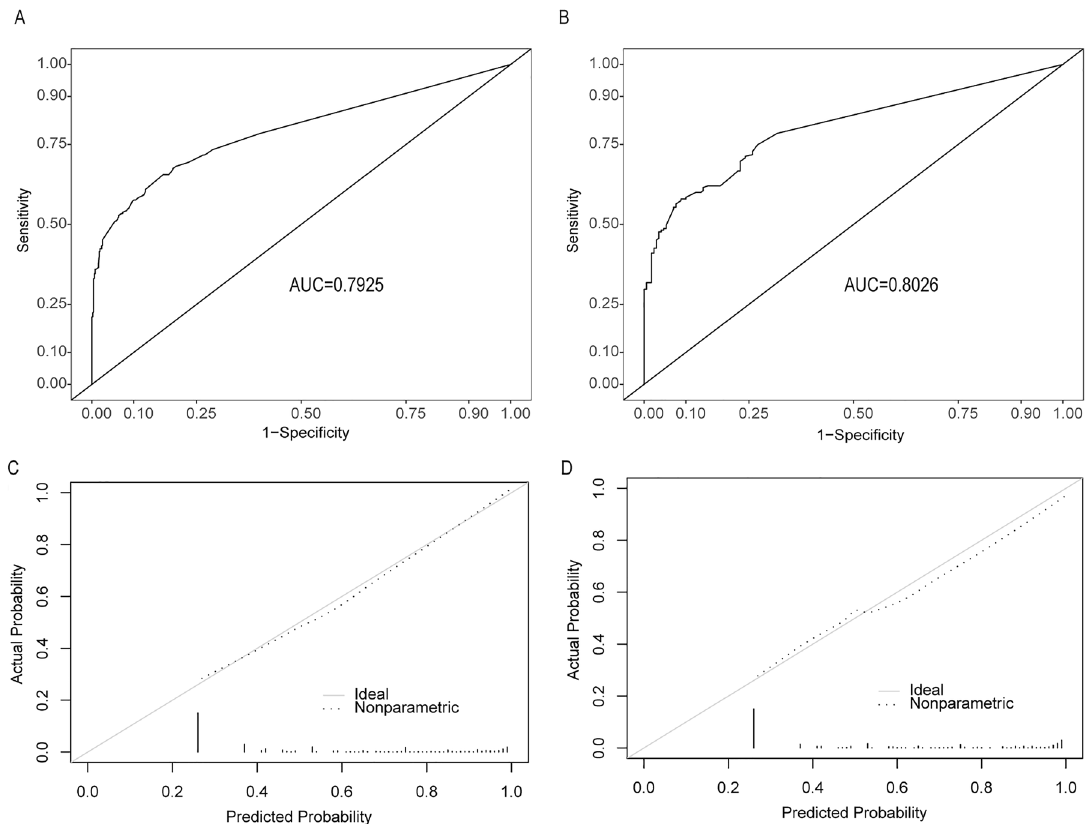
Figure 3. ROC curves and calibration curve of the APE risk prediction model. (A) ROC curve and corresponding AUC for the prediction model of APE diagnosis in the training set. (B) ROC curve and corresponding AUC for the prediction model of APE diagnosis in the testing set. (C) The calibration curve of training set. (D) The calibration curve of testing set. ROC receiver operator characteristics, AUC area under the receiver operator characteristics curves. The figures were created using R software